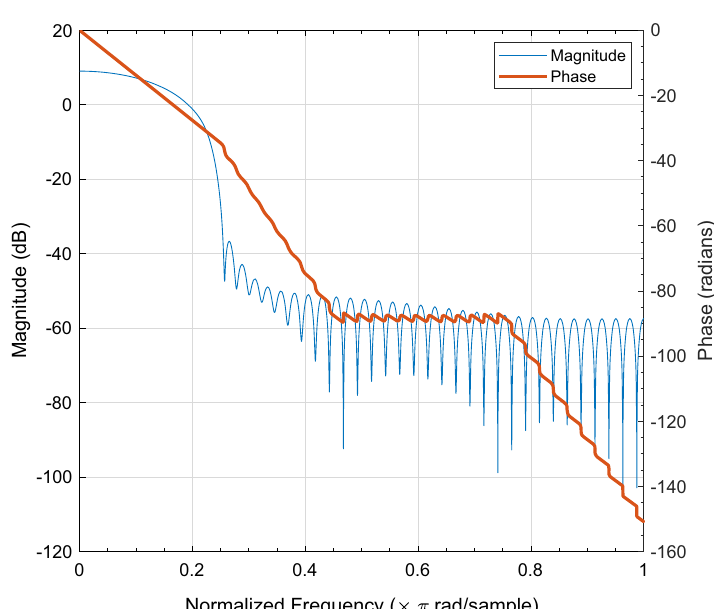
Fig. 5 Magnitude and phase responses of the filter f 1 depicted in Fig.